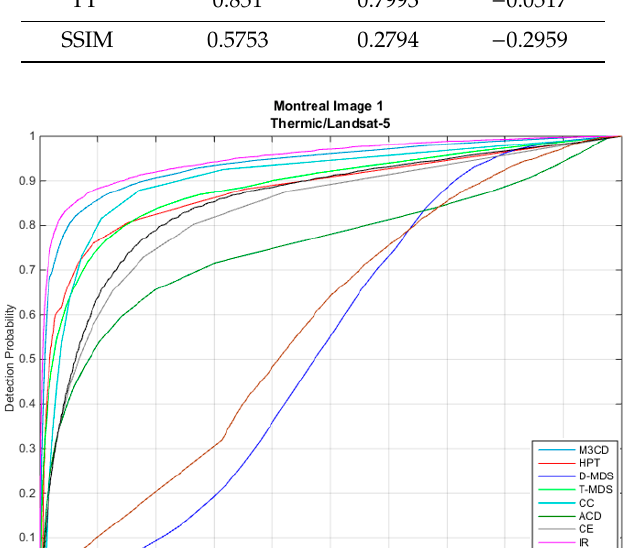
Figure 6. Image pair-2: Landsat5 NIR band/Optical.